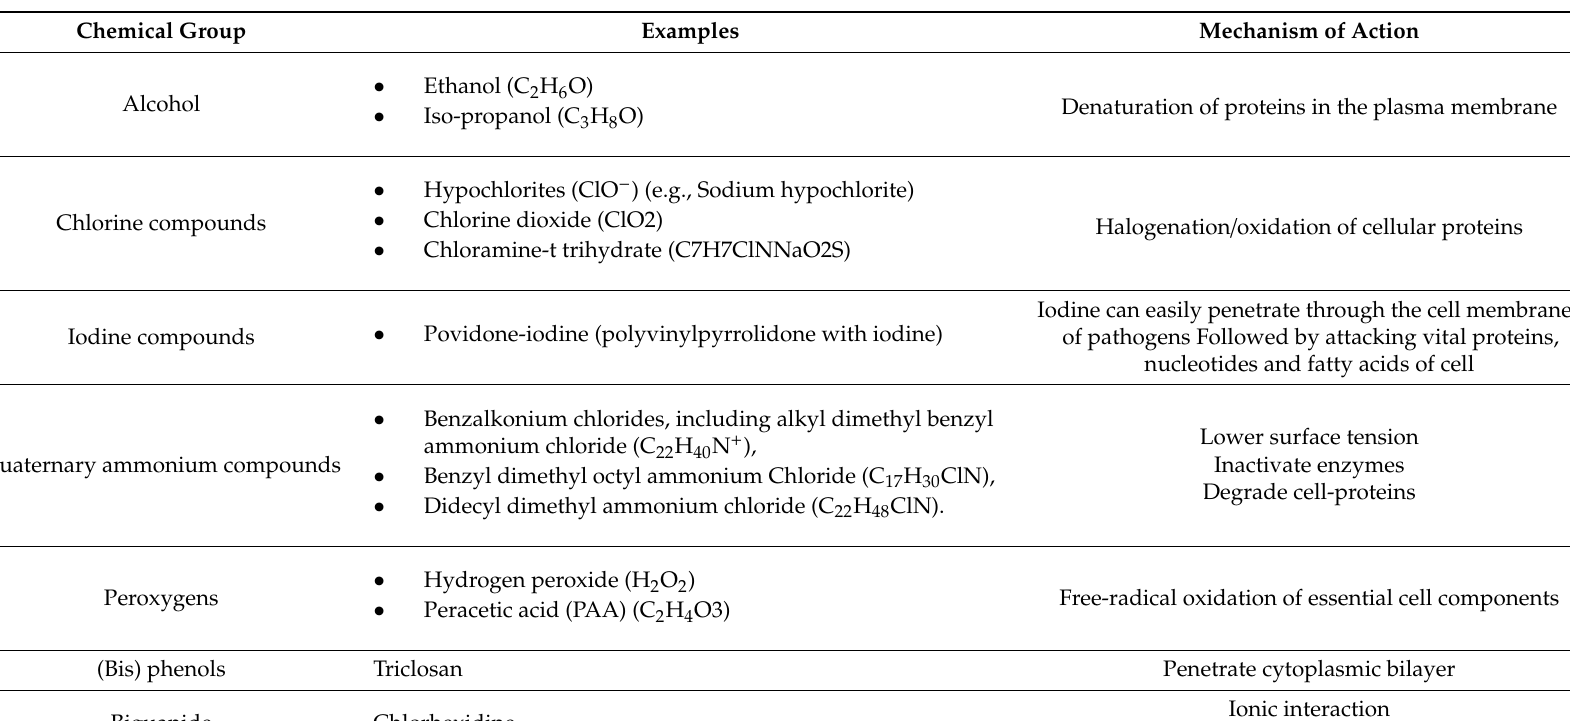
Table 1. Chemical classification of commonly used disinfectants in hand sanitizer and their mechanism of antimicrobial